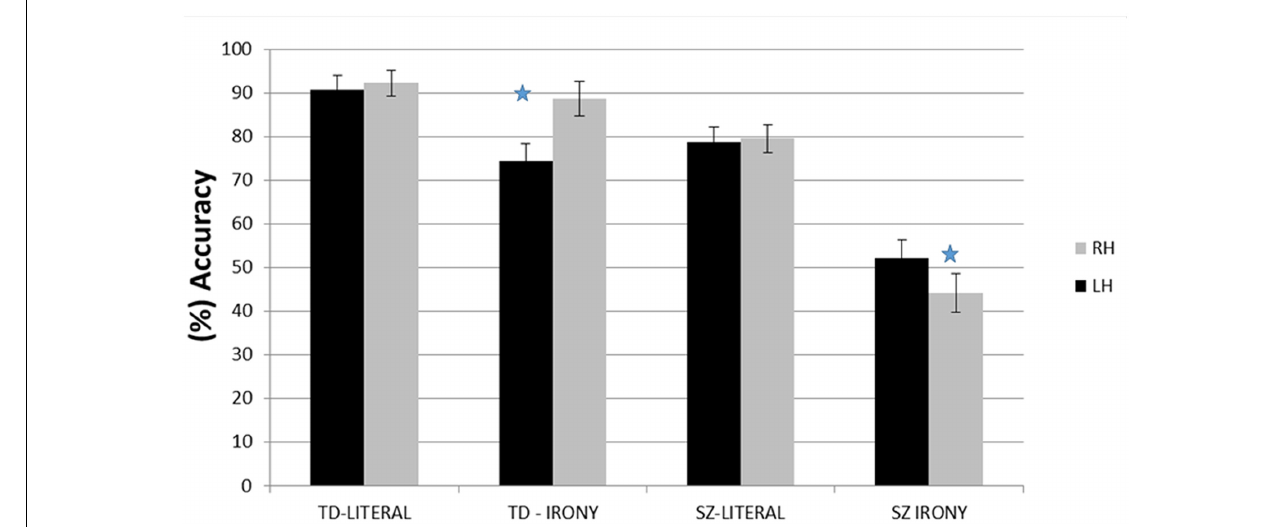
FIGURE 1 | Percent of correct responses (and SE) within each hemisphere, by group and stimuli type. ∗ p <